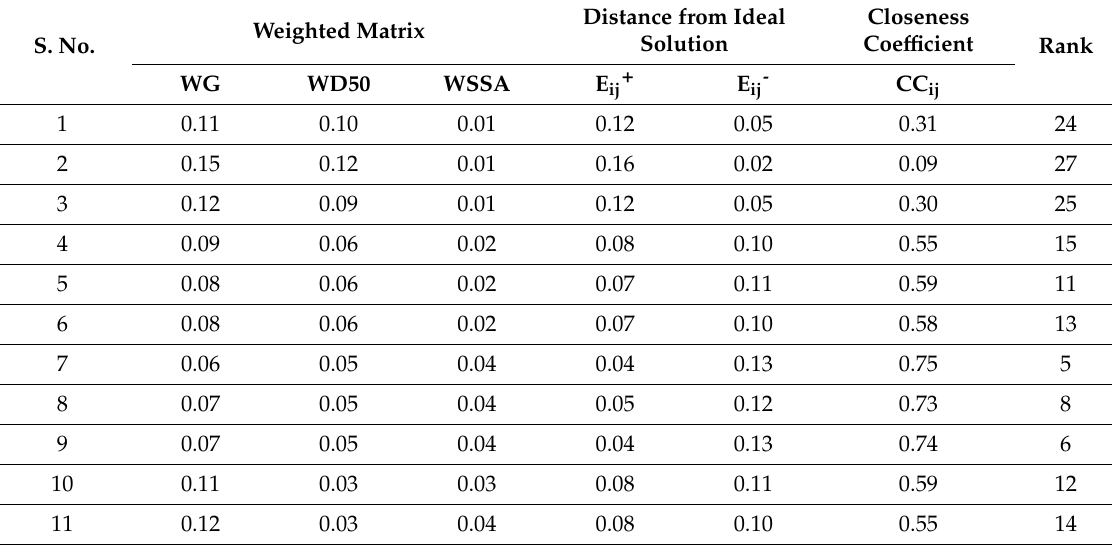
Figure 6. Technique for the order of preference by similarity to the ideal solution (TOPSIS) methodology for ball milling and wire-electrical discharge machining (WEDM) cutting. Table 5. TOPSIS evaluation for ball